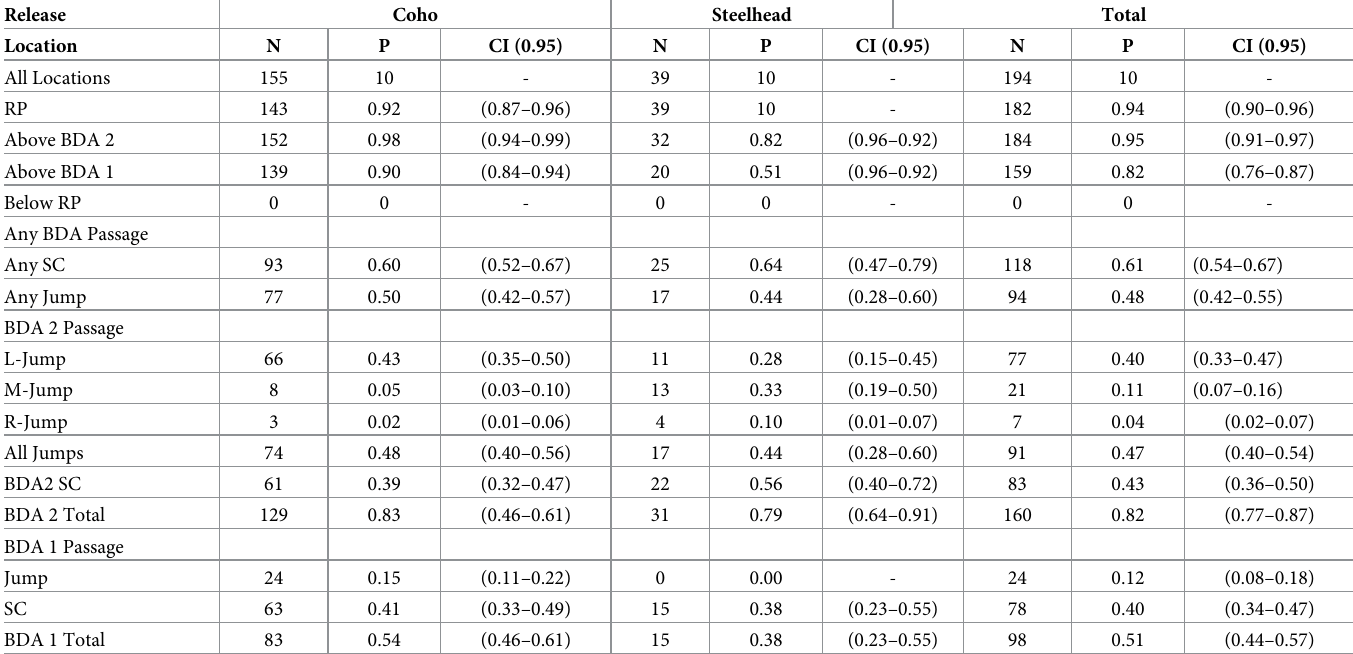
Table 1. Summary of detection and movement of 194 juvenile coho salmon (C) and steelhead trout (S) placed in a release pool (RP) downstream of beaver dam ana- logues 1 and 2 in October, 2017: SC = Side Channel; L, M and R = left, middle and right, respectively, looking upstream; N = sample size, P = proportion; upper and lower 95% confidence intervals (CI) are in